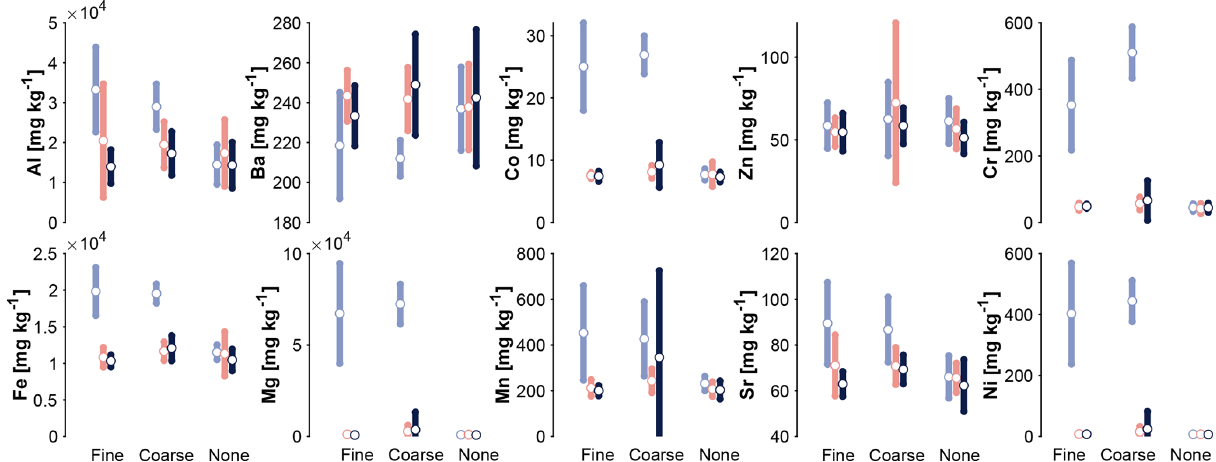
Figure 8. Averaged trace element concentrations in the solid soil material, differentiated by olivine treatment (grouping) and depth (blue: 2–4cm; red: 10–12cm; black: 18–20cm below surface). Error bars indicate 1 standard deviation. Data are separated by plant type in Sup- plement S8 (topsoil